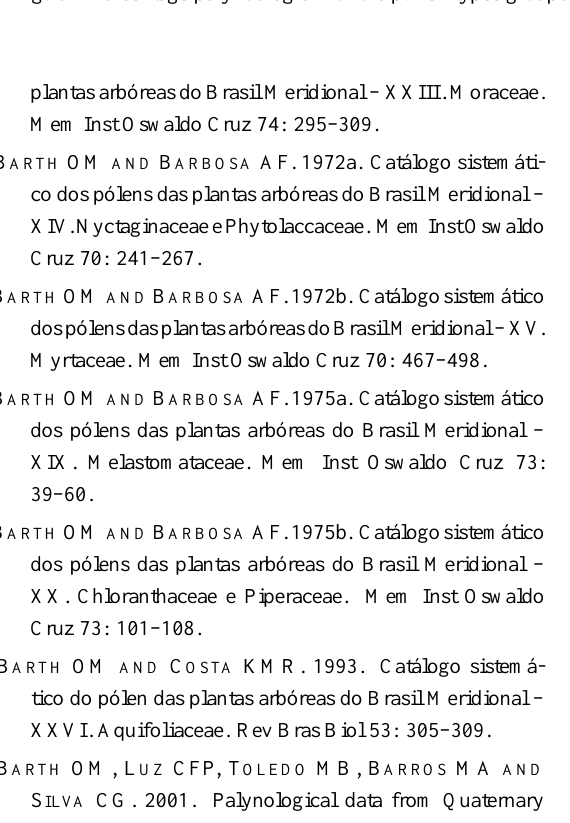
Fig. 6 – Percentage palynodiagram of the pollen types grouped into Hygrophytes, Wide Distribution and Exotic Genera.